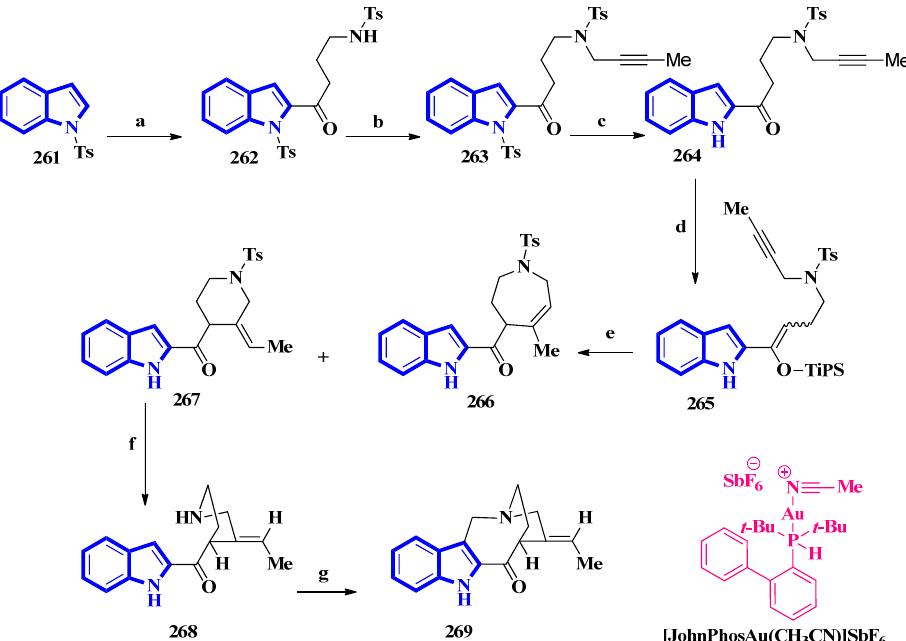
Figure 16. The total synthesis of (±)-conolidine 269 . (a) n -BuLi, THF, − 78 °C, 5 min, then rt, 1 h, then N -tosylpyrrolidonein THF, − 30 °C to − 15 °C, 4 h, 48%; (b) K 2 CO 3 , 1-bromo-2-butyne, CH 3 CN, 80 °C, 94%; (c) TBAF, CH 3 CN 35 °C, 15 h, 93%; (d) TiPSOTf, 2,6-lutidine, 35 °C, 5 h, 97%, E:Z = (e) [JohnPhosAu(CH 3 CN)]SbF6, H 2 O, toluene, 60 ◦ C, 2 h, 15% for 266, 73% for 267; (f)